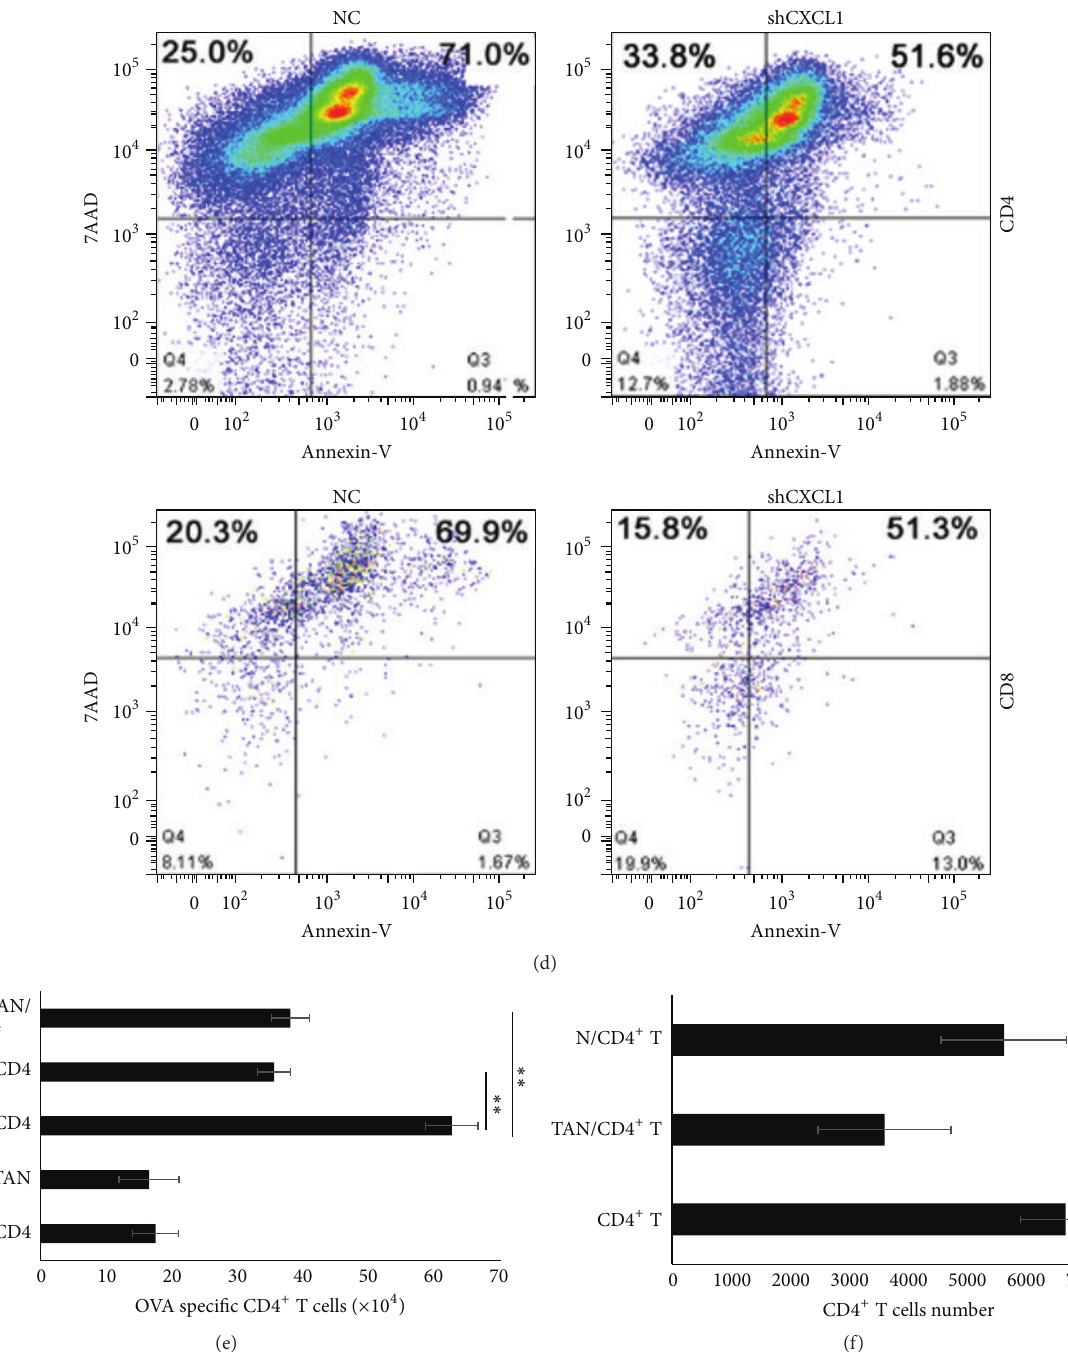
Figure 4: Tumor-infiltrating neutrophils in tumor inhibit T cell proliferation. Number of CD3 + CD4 + and CD3 + CD8 + T cells in the spleen (a) and tumor tissues (b) at day 14 after tumor inoculation were analyzed by flow cytometric. (c) Fas/FasL expression on splenic CD11b + Ly6G + neutrophils or TANs from 3LL/NC bearing mice, 3LL/shCXCL1 bearing, or na¨ıve mice were analyzed by cytometric analysis. (d) CD4 + T or CD8 + T cells derived from tumor tissues were stained with 7AAD and Annexin-V, flow cytometric analysis of apoptotic/necrotic CD4 + T, and CD8 + T cells. (e) Splenic CD4 + T plus conventional dendritic cells together with or without CD11b + Ly6G + neutrophils were cocultured for 3 days with 10 𝜇 g/mL OVA; CD4 + T cells were counted by flow cytometry. (f) Splenic CD4 + T and TANs were cocultured for 3 days with anti-CD3 and anti-CD28 and IL-2, CD4 + T cells numbers were counted by flow cytometry. N (splenic neutrophils); TAN (tumor-associated neutrophils). ∗∗ 𝑝 < 0.01 . Data are presented as means ±